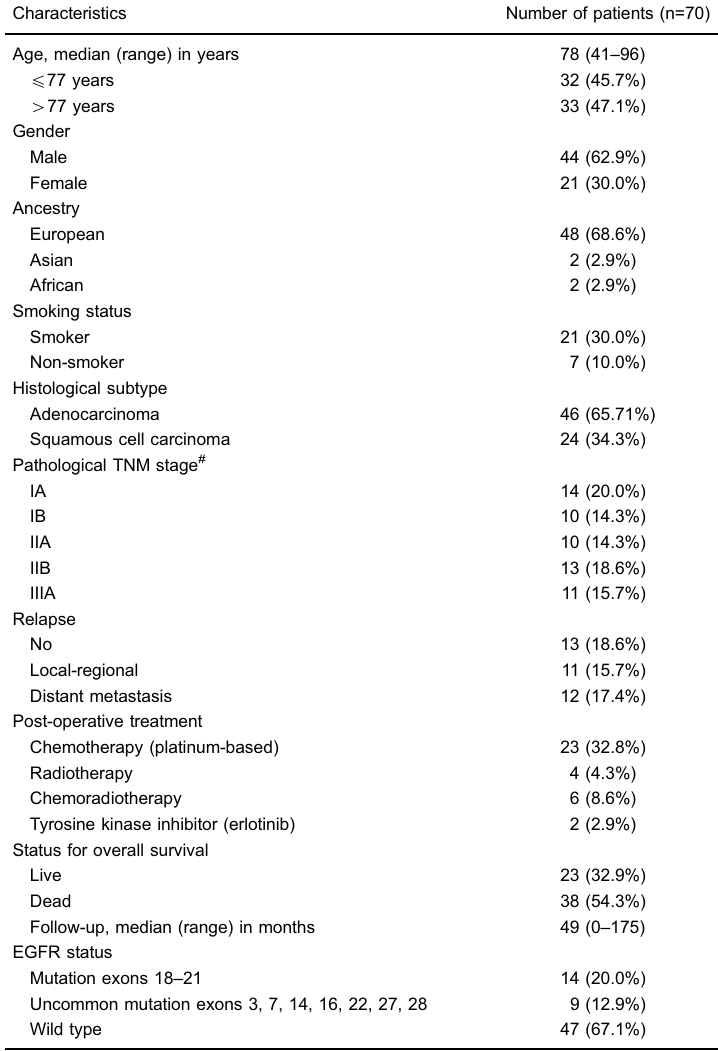
Table 1. Frequency of demographic and clinical characteristics of 70 NSCLC